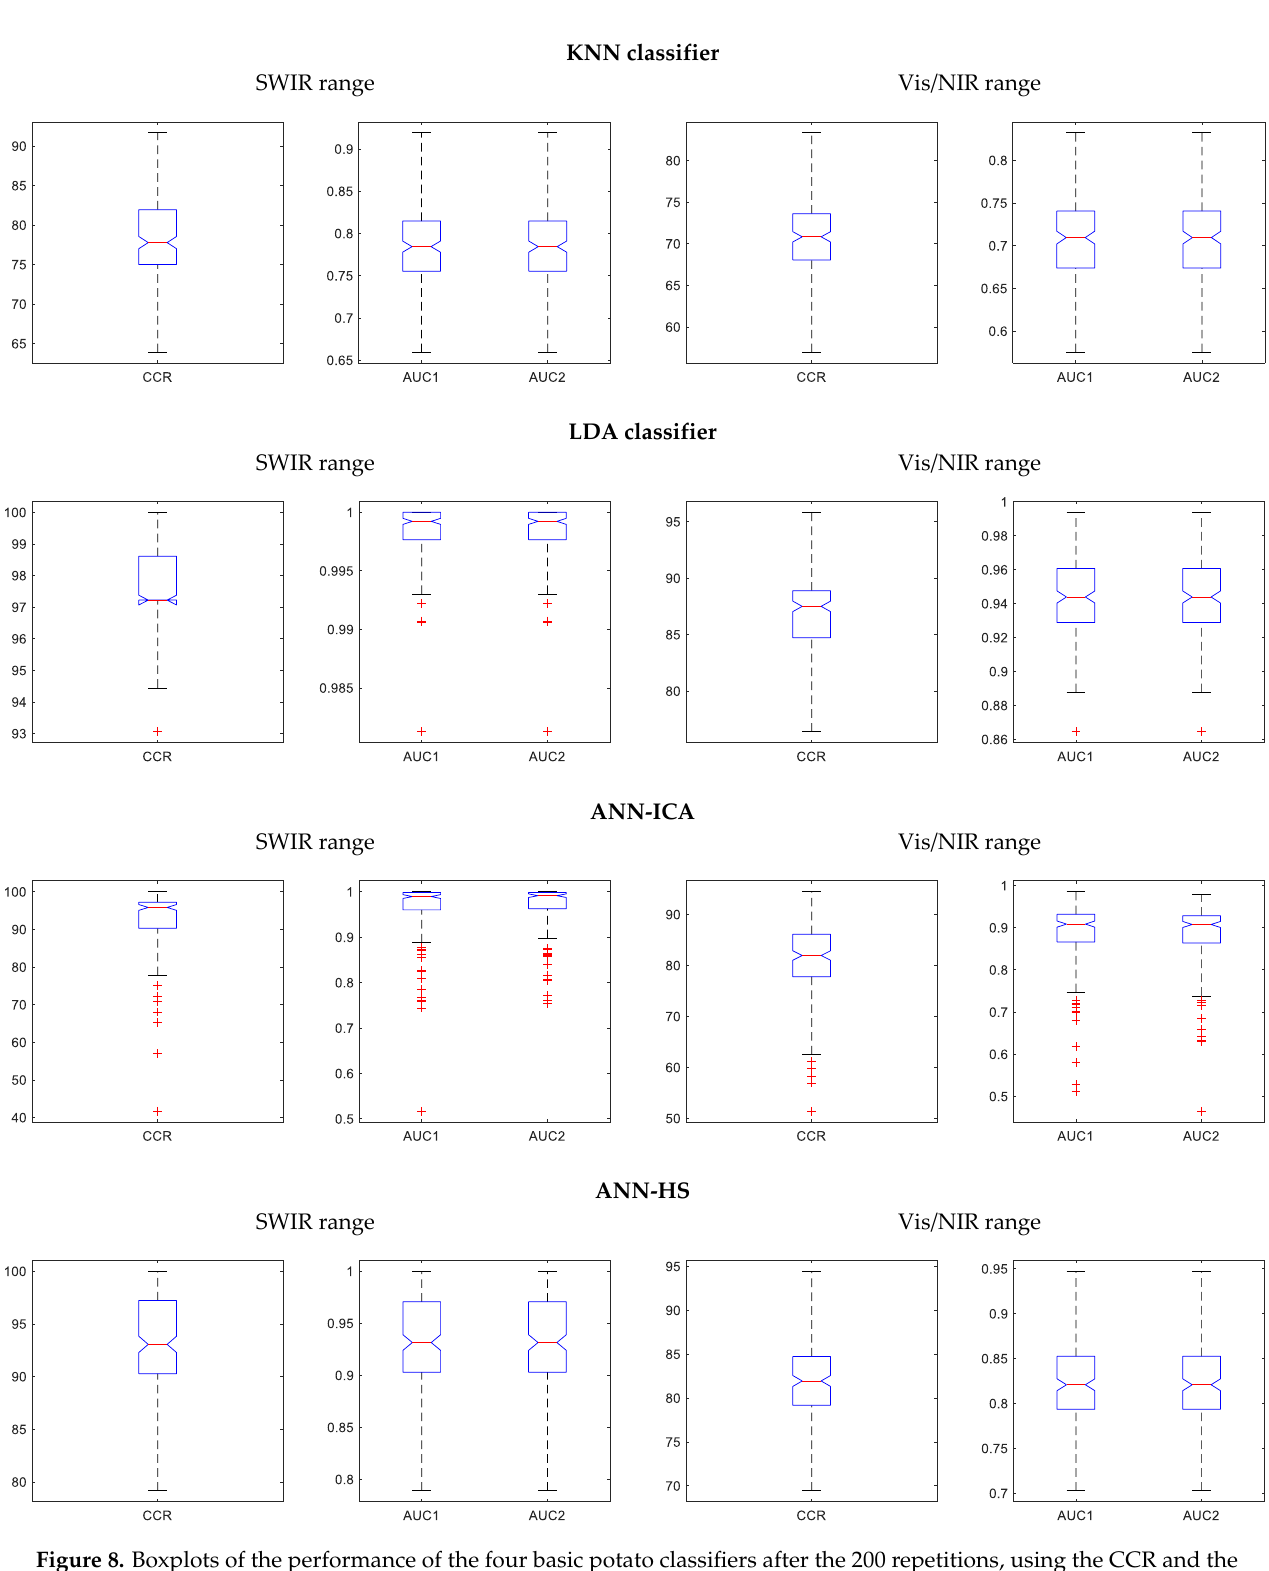
Figure 8. Boxplots of the performance of the four basic potato classifiers after the 200 repetitions, using the CCR and the AUC, over the two spectral ranges under consideration, SWIR and Vis/NIR.